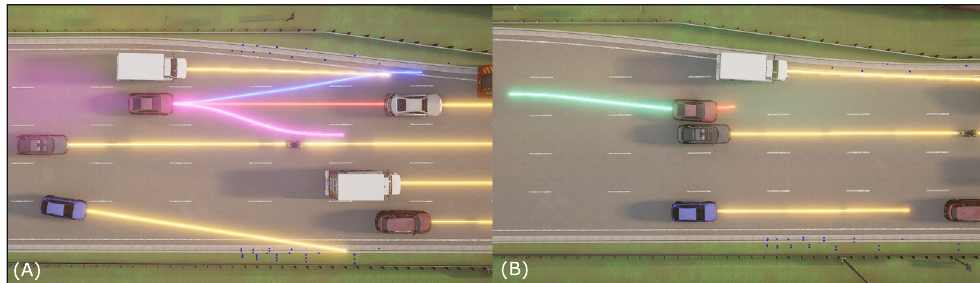
Figure 10. ( A ) Possible generated paths. ( B ) Final position of